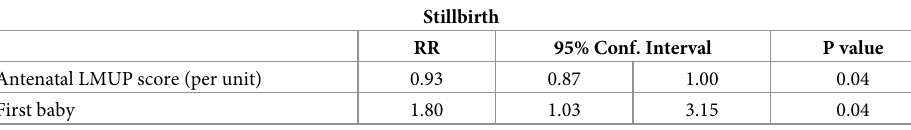
Table 6. Multivariable regression of pregnancy intention and